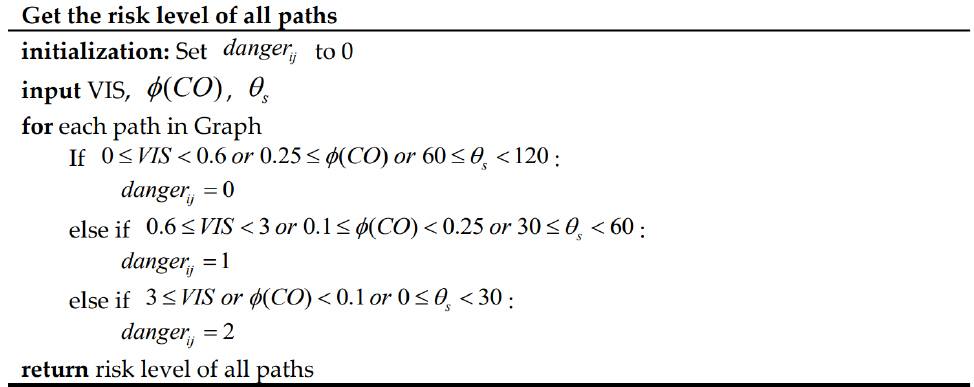
Figure 2. Pseudocode for judging path risk